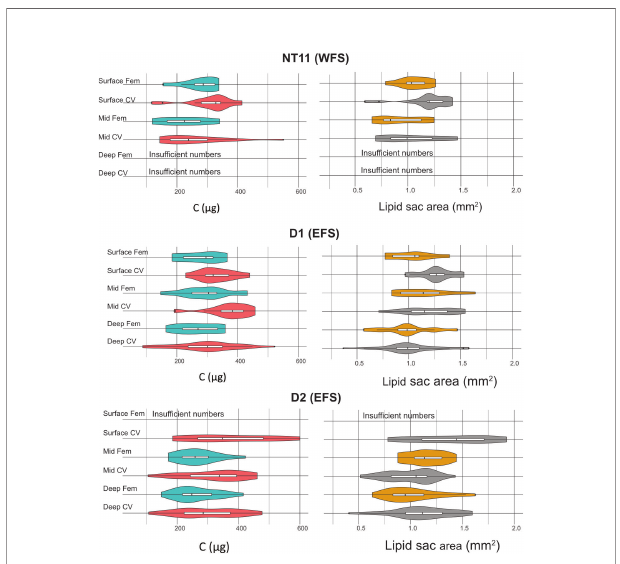
FIGURE 5 | Calanus fi nmarchicus : distribution of carbon total weight (µg, left) and lipid sac area (mm 2 , right) in CV and females in the upper, mid, and deep depth strata at stations NT11, D1 and D2.